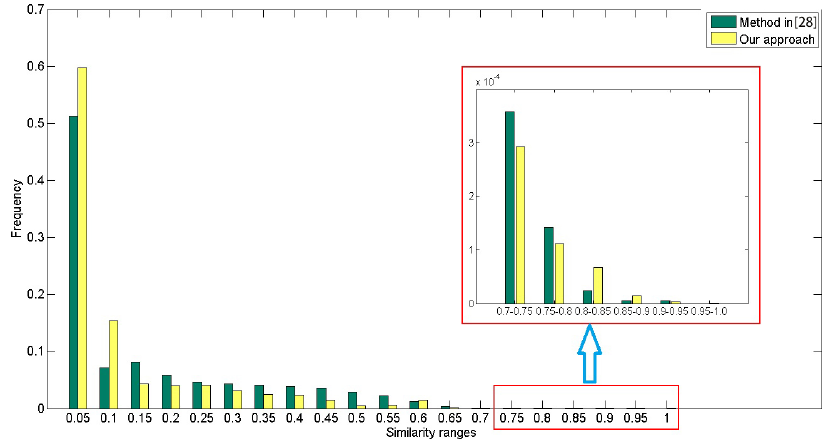
Figure 10. Comparison chart of the similarity histograms for the reference scene I.